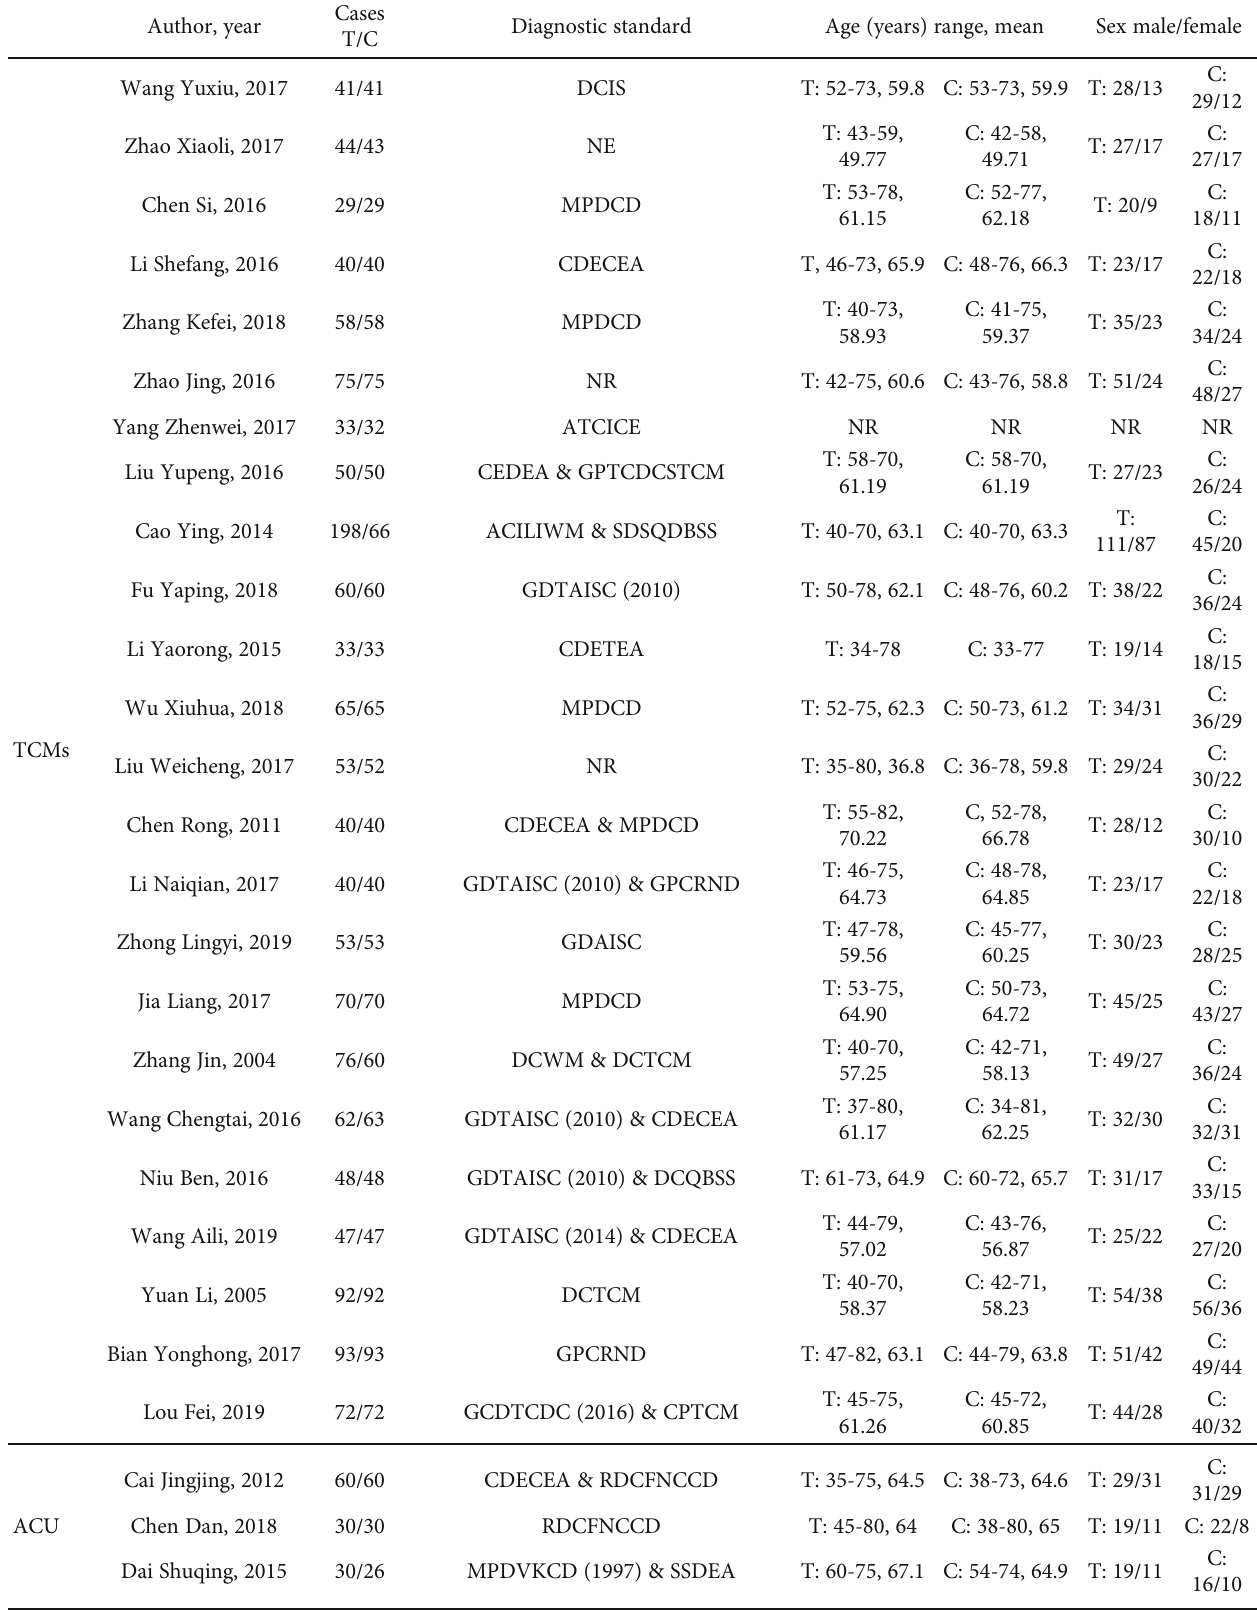
Table 1: Characteristics of included